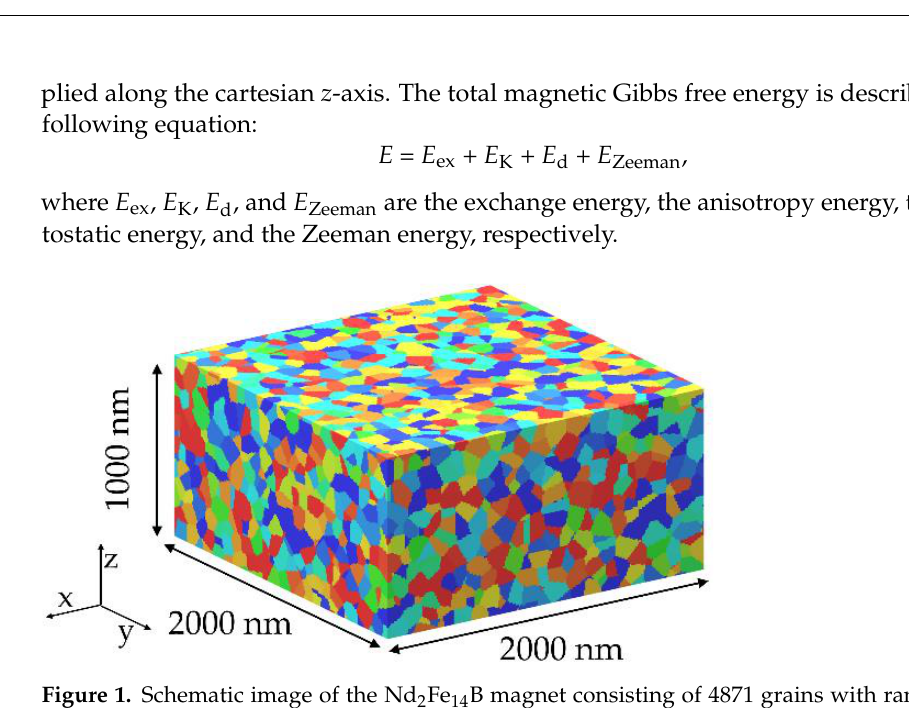
Figure 1. Schematic image of the Nd 2 Fe 14 B magnet consisting of 4871 grains with randomly distributed anisotropy directions.